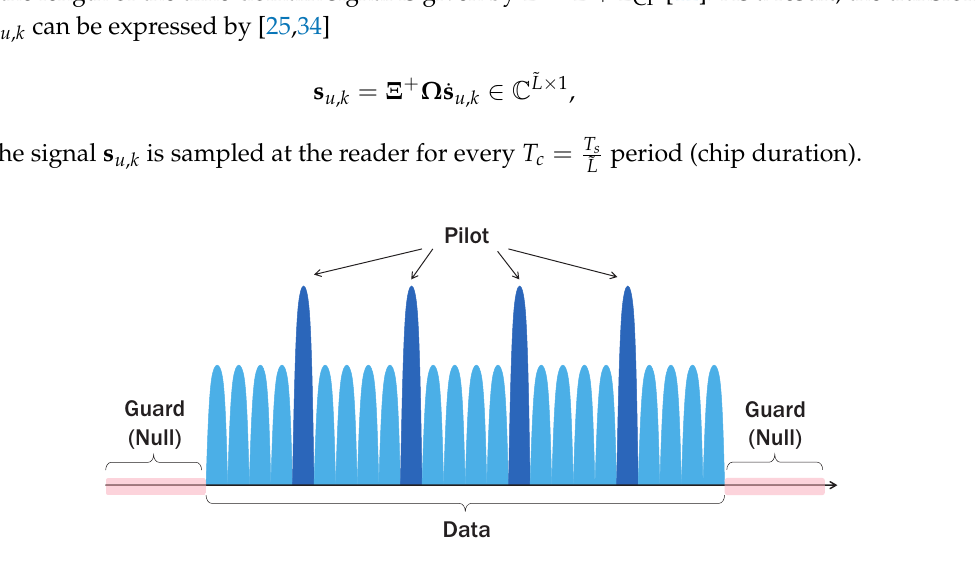
Figure 2. General structure of OFDM carrier in frequency